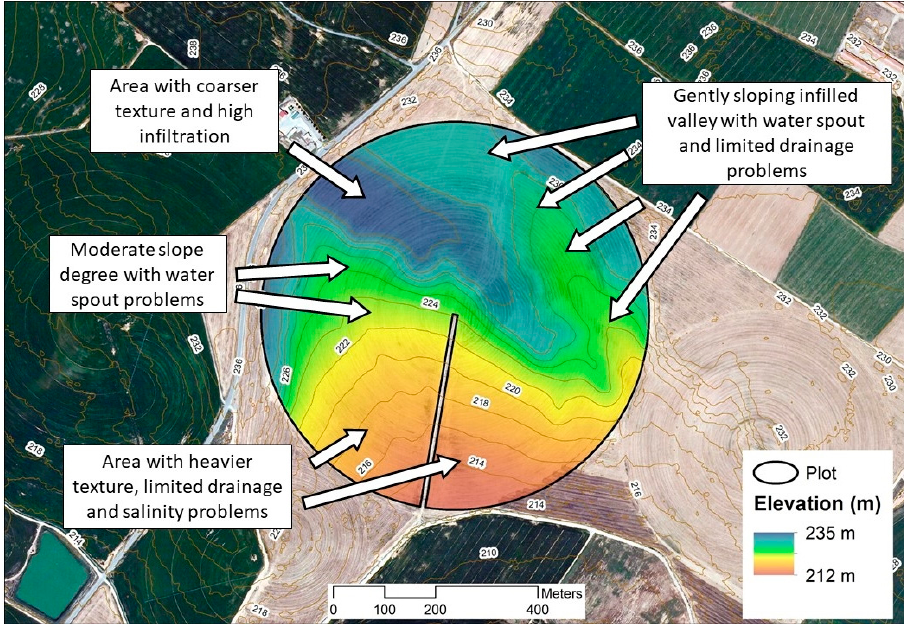
Figure 4. Knowledge of the farmer about soil characteristics and problems in the study plot localized on top of elevation data.